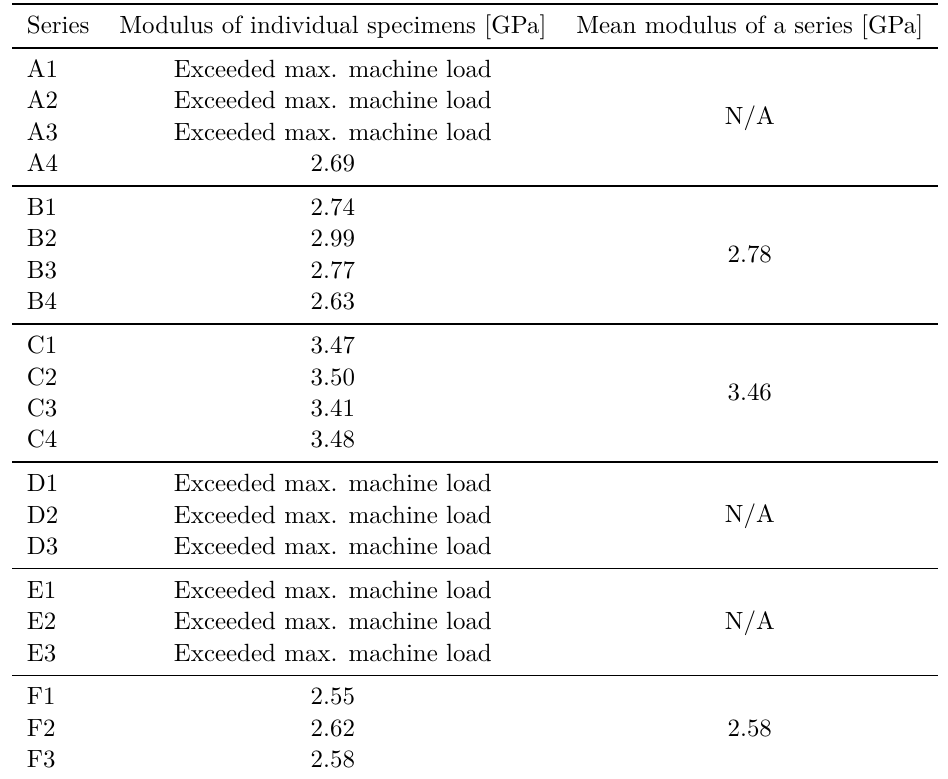
Table 2. Values of all Young’s moduli calculated from individual series of specimens according to ISO 13314 [5]. Some series of experiments exceeded the maximum value of appliable load, more on this topic in section Conclusions.